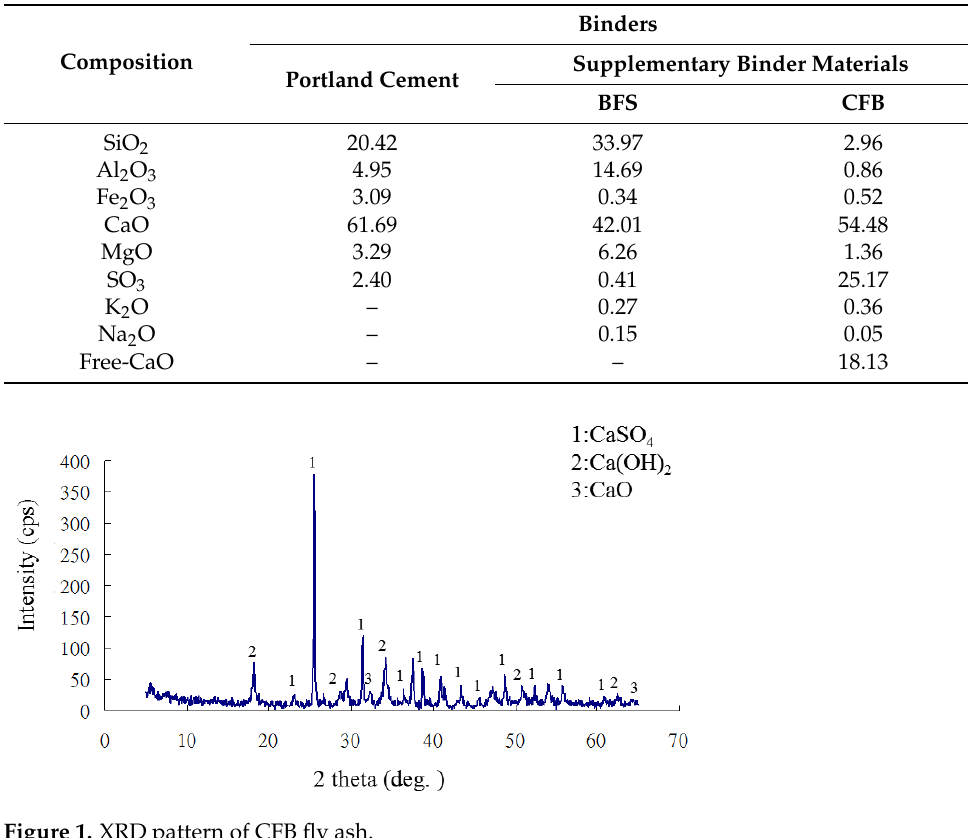
Table 1. Chemical composition of binders (wt%).